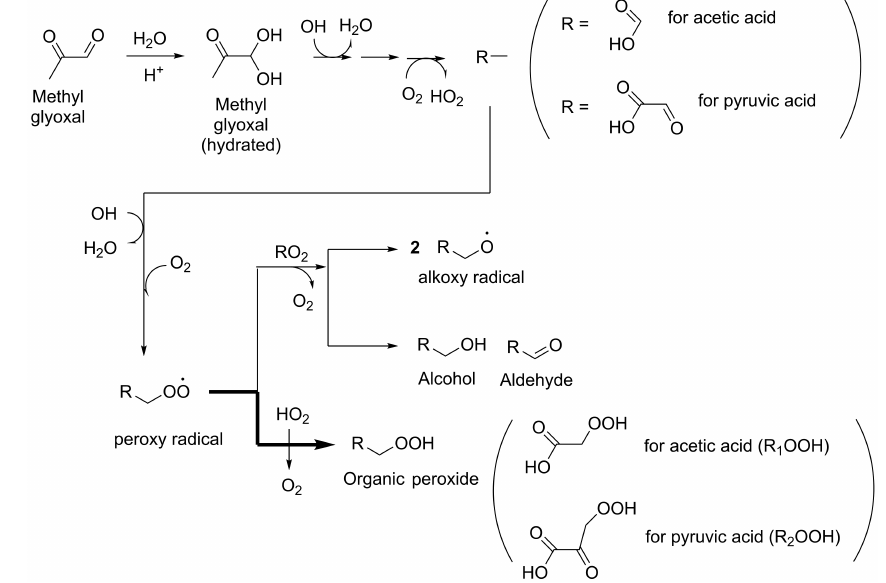
Figure 1. Organic peroxide formation from aqueous-phase OH radical reactions of